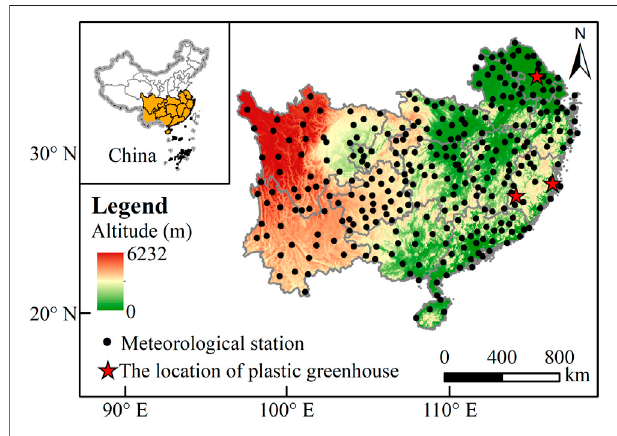
FIGURE 1 | Geographic location of study area and meteorological